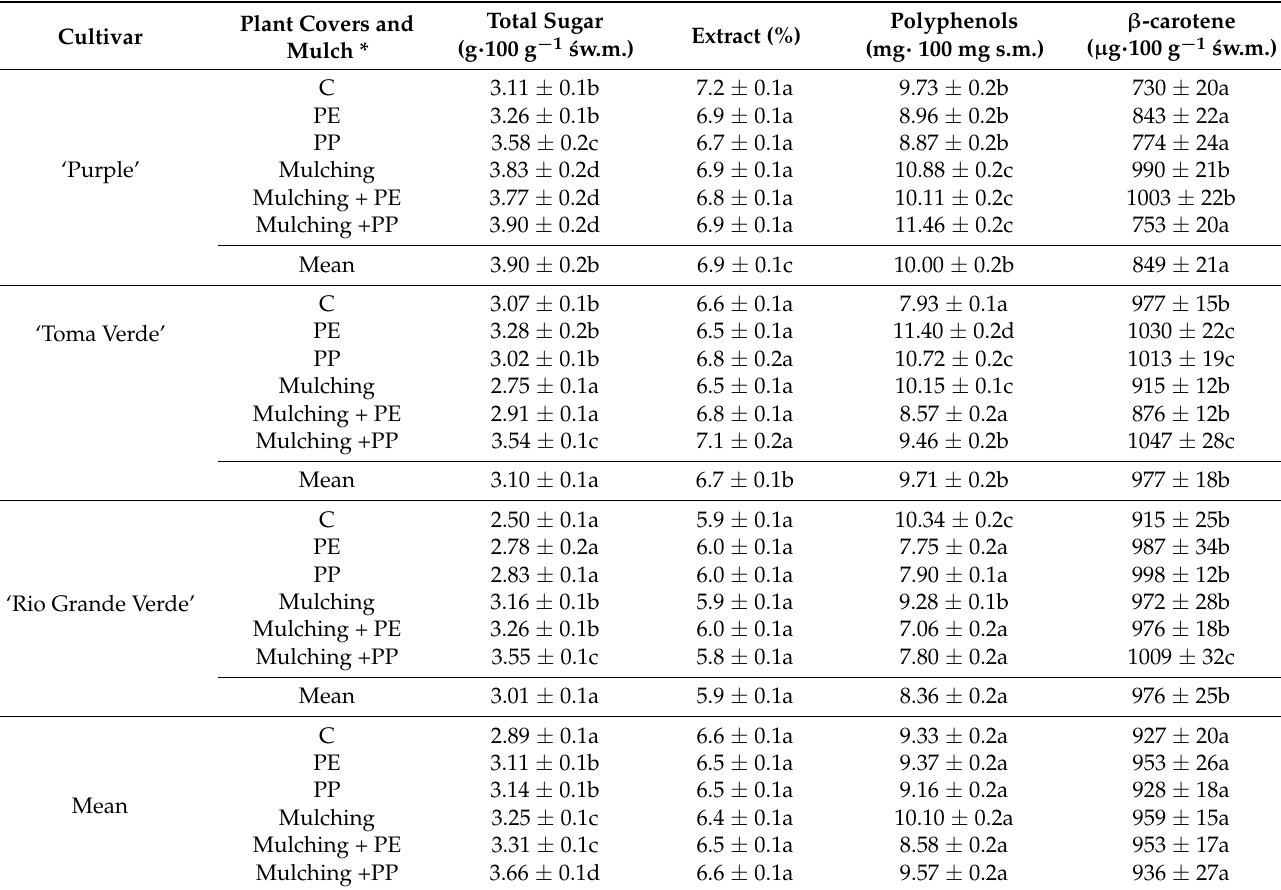
Table 12. The effects of cultivar, plant cover and soil mulching on the totalsugar extract, polyphenols and β -carotene of tomatillo fruit (means of 2015,